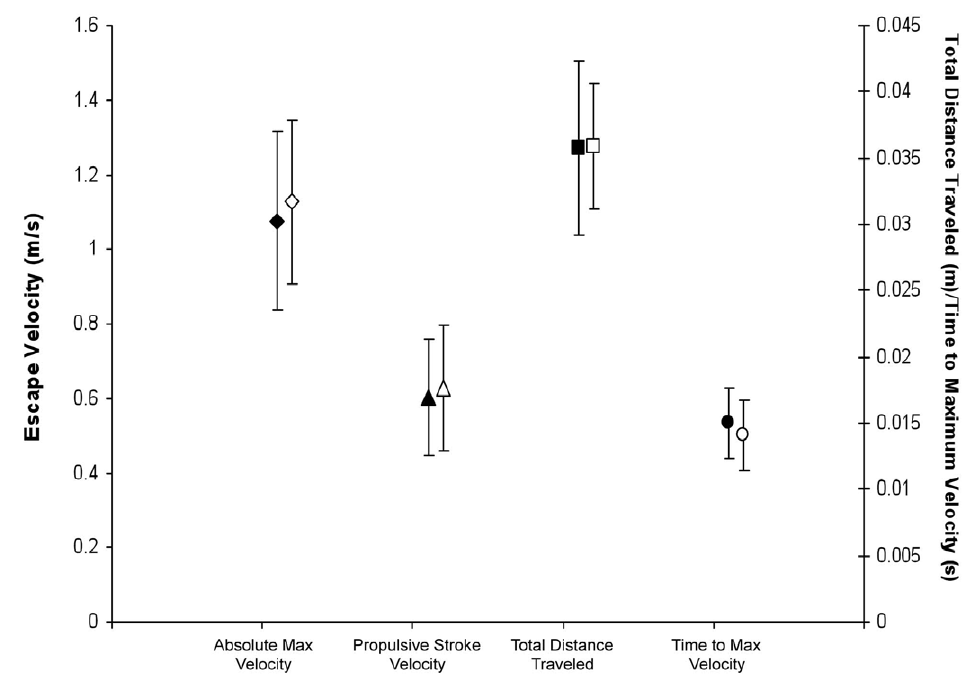
Figure 5. A comparison of performance before and after removal of the sword. Overall C-start escape performance is shown as an average for all individuals. Solid markers represent averages before the swords were removed, while hollow markers represent averages after removal. The same four performance variables are compared as in Figs. 3 and 4. whiskers represent 6 1 standard deviation. There is no significant change in any performance variable after the sword is removed.